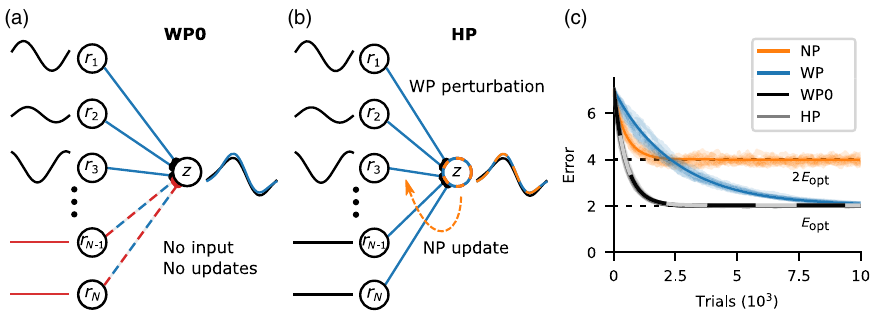
FIG. 6. New learning rules and learning of tasks consisting of multiple subtasks. (a) WP0 does not update weights that mediate zero input, avoiding their diffusion. (b) Hybrid perturbation (HP): NP scheme with output perturbations induced by WP. (c) WP converges approximately P ¼ 5 (number of subtasks) times slower than NP, but in the presence of unrealizable target components [or for finite σ < T ; Supplemental Material Sec. III, Eqs. (S87) – (S89) [28] ] to a lower final error. For the used maximally sparse and equally and N trial eff strong inputs, WP0 and HP combine the higher convergence rate of NP with the low final error of WP. Error curves (solid, theoretical predictions; shaded, ten exemplary runs) are for M ¼ 10 , N; T ¼ 100 , N task